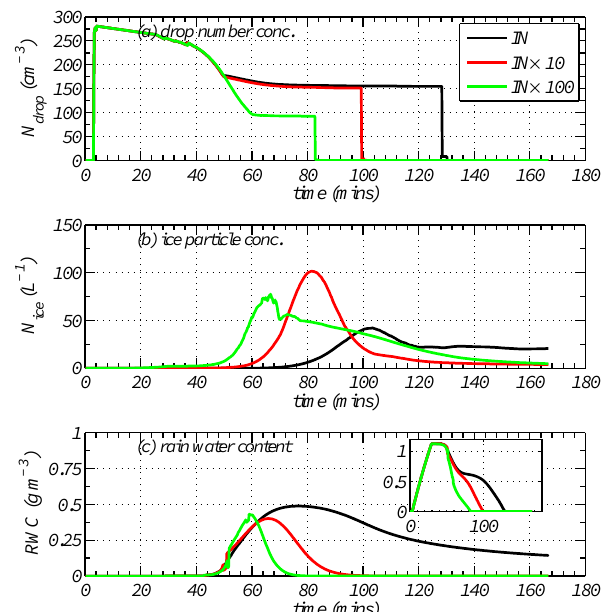
Fig. 14. As Fig. 12, except black lines correspond to a run with the Internal mixture assumption (see schematic in Fig. 6a and text) and the Hall (1980) collision kernel and the red lines are the same but with the collision kernel enhanced by turbulence (following Pinsky et al., 1999). The Pinsky et al. (1999) kernel results in a reduction of the drop concentration commensurate to what was measured by the aircraft (Fig. 3) this is followed by rapid ice multiplication.